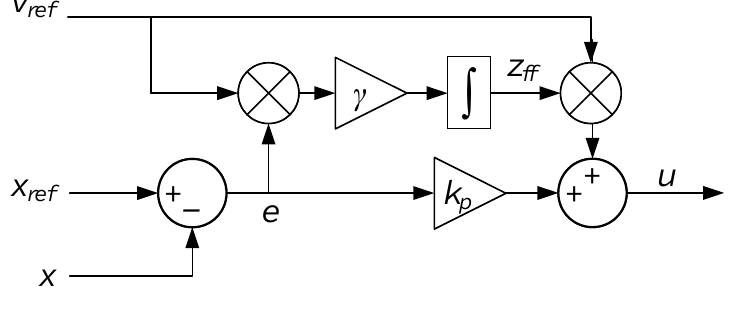
Figure 4. MIT-rule adaptive